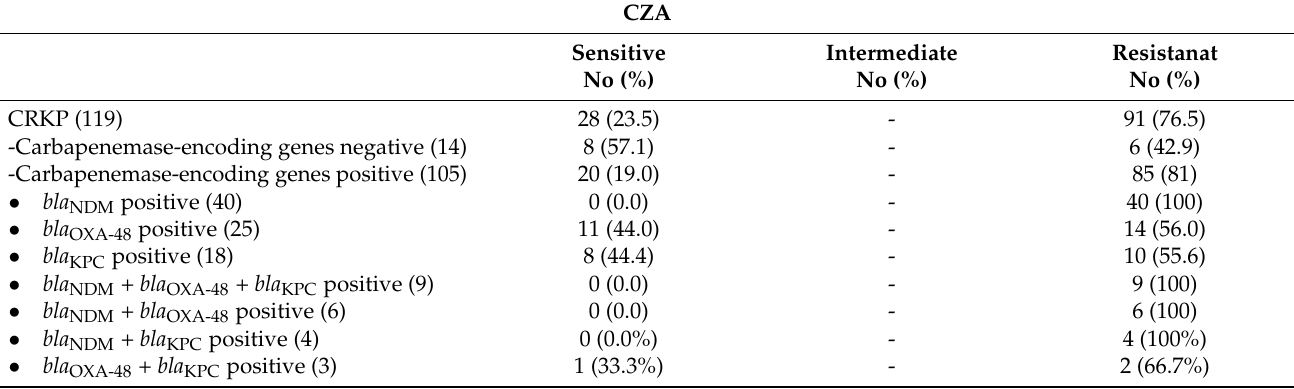
Table 8. Susceptibility of CRKP isolates to